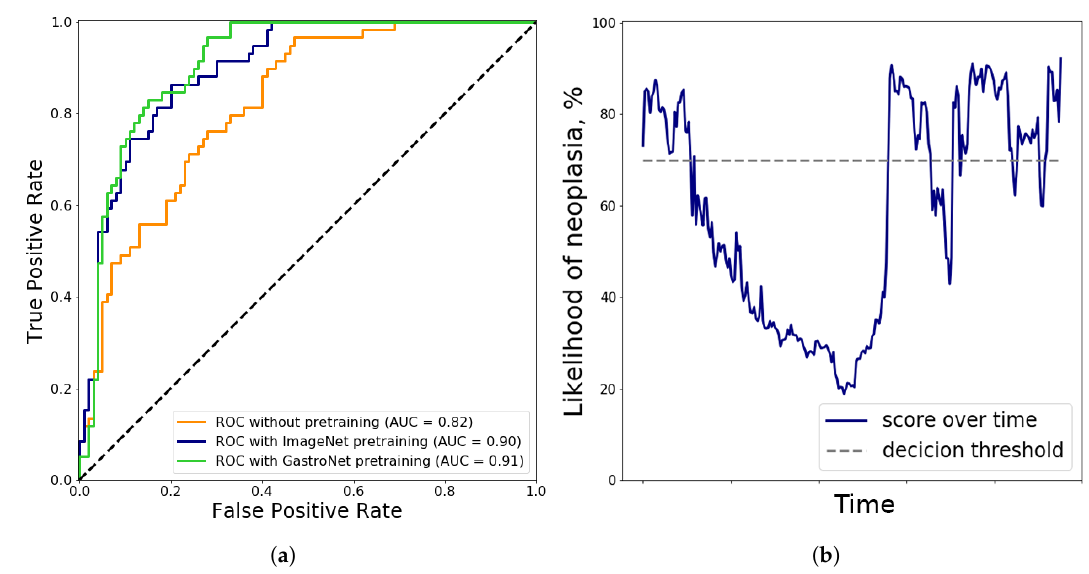
Figure 3. ( a ) ROC curves of the three ensemble models. ( b ) Example of dysplasia score over